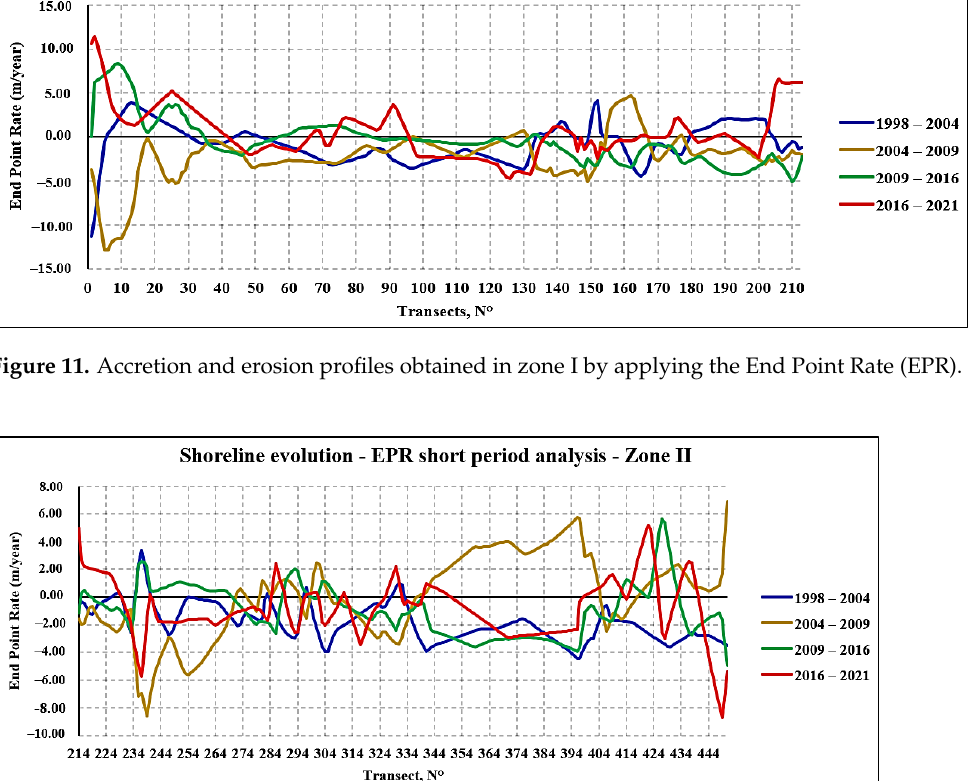
Figure 12. Accretion and erosion profiles obtained in zone II by applying the End Point Rate (EPR).